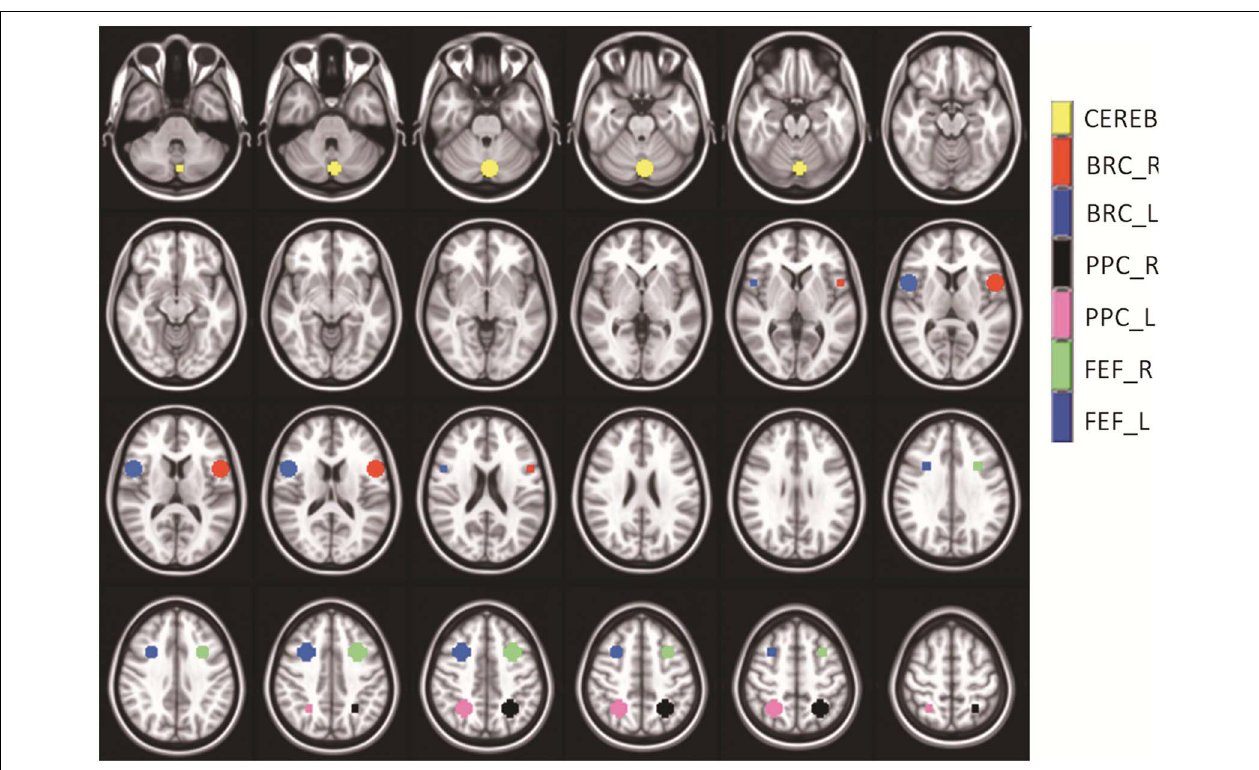
FIGURE 2 | Series of axial images showing the average masks with one standard deviation used within the analysis. The cerebellar vermis (yellow), Broca-Right (red), Broca-Left (dark blue), Posterior Parietal Cortex–Right (black), Posterior Parietal Cortex–Left